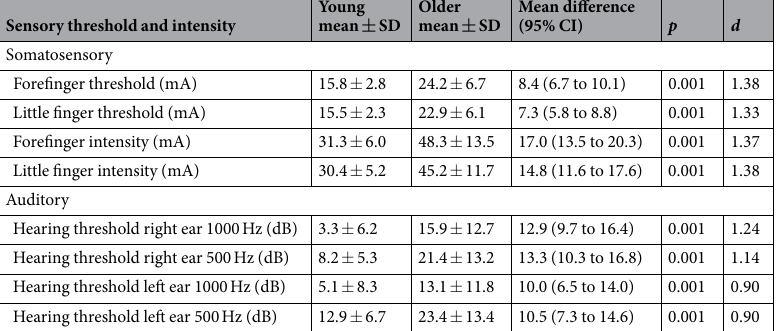
Table 6. Sensory thresholds and stimulus intensities. The differences between age groups were tested with independent samples t -tests (two-tailed, bootstrap statistics). SD, standard deviation; CI, confidence interval; p , statistical significance; d , Cohen’s d